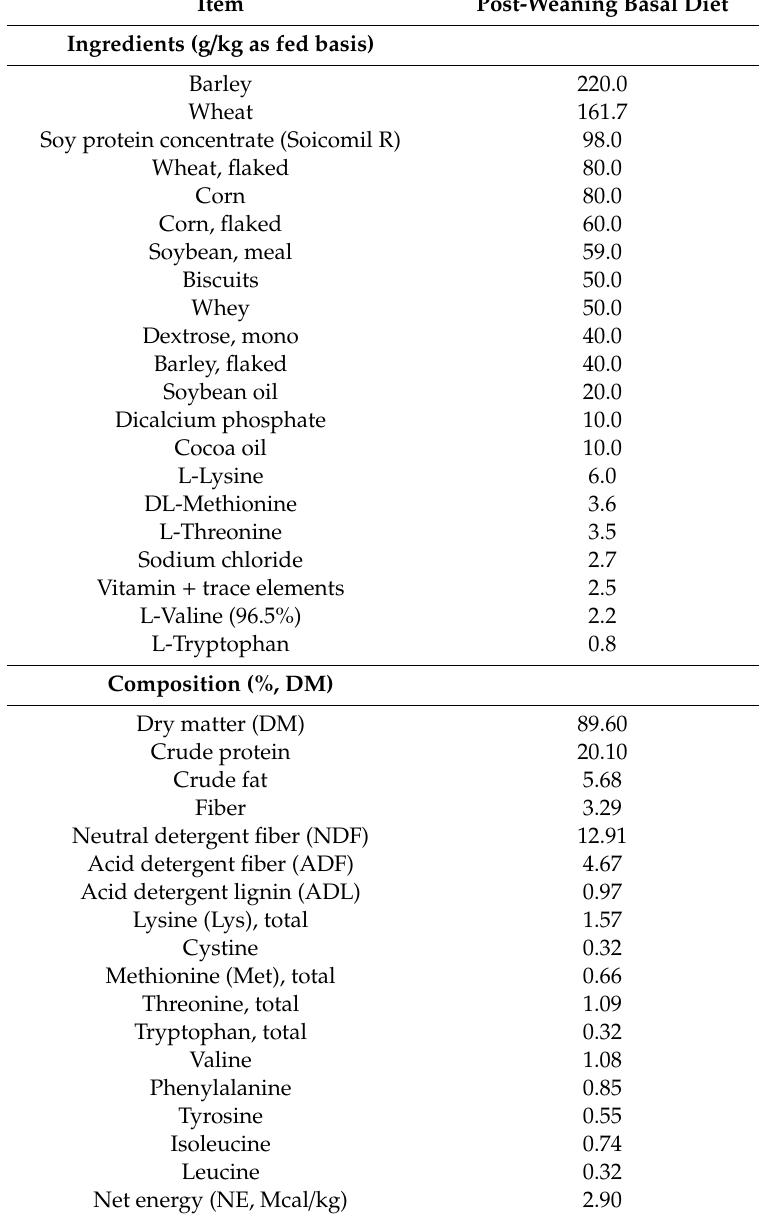
Table 3. Ingredients and Chemical Composition of the Basal Diet (CT) of post-weaning piglets. Seaweed powder (SW) was added to the basal diet at 4 g / kg feed